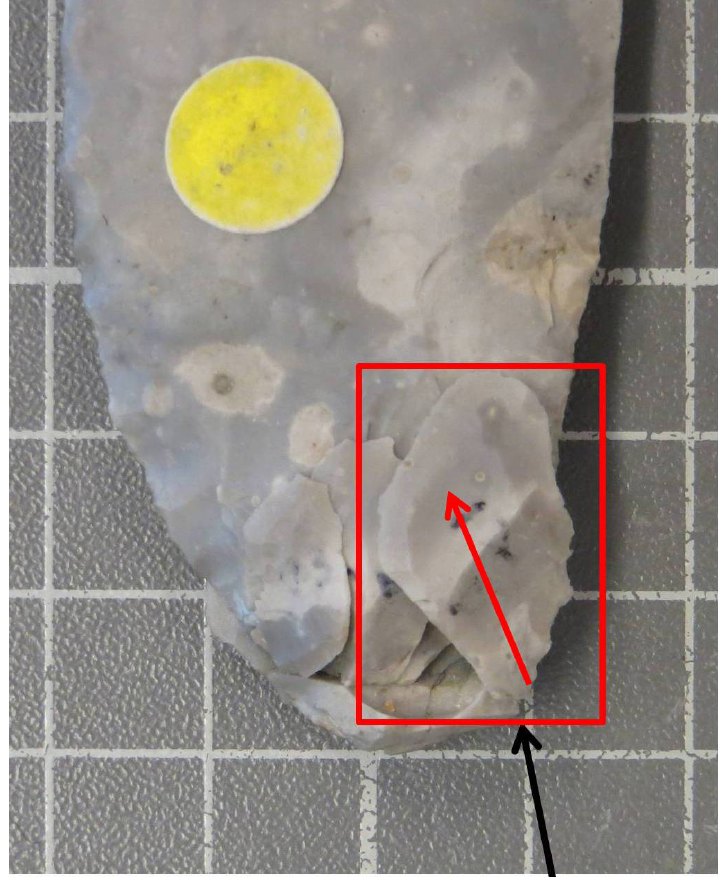
Figure 5. Blade-point 4.2, flake v2d with the black arrow indicating direction of removal blow and the red arrow showing the direction of dorsal rippling (photograph by the author). Gridlines on this image are 10mm apart. After this bulbar thinning episode the knapper seems to have turned the blade over to begin a sequence of dorsal